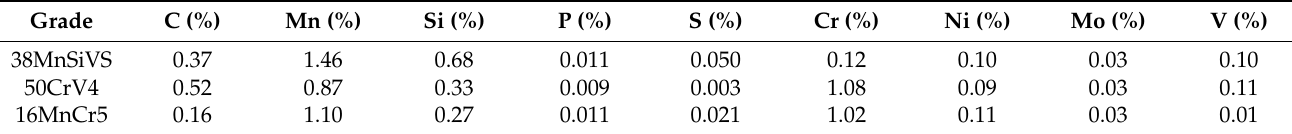
Table 2. Chemical composition of 16MnCr5.